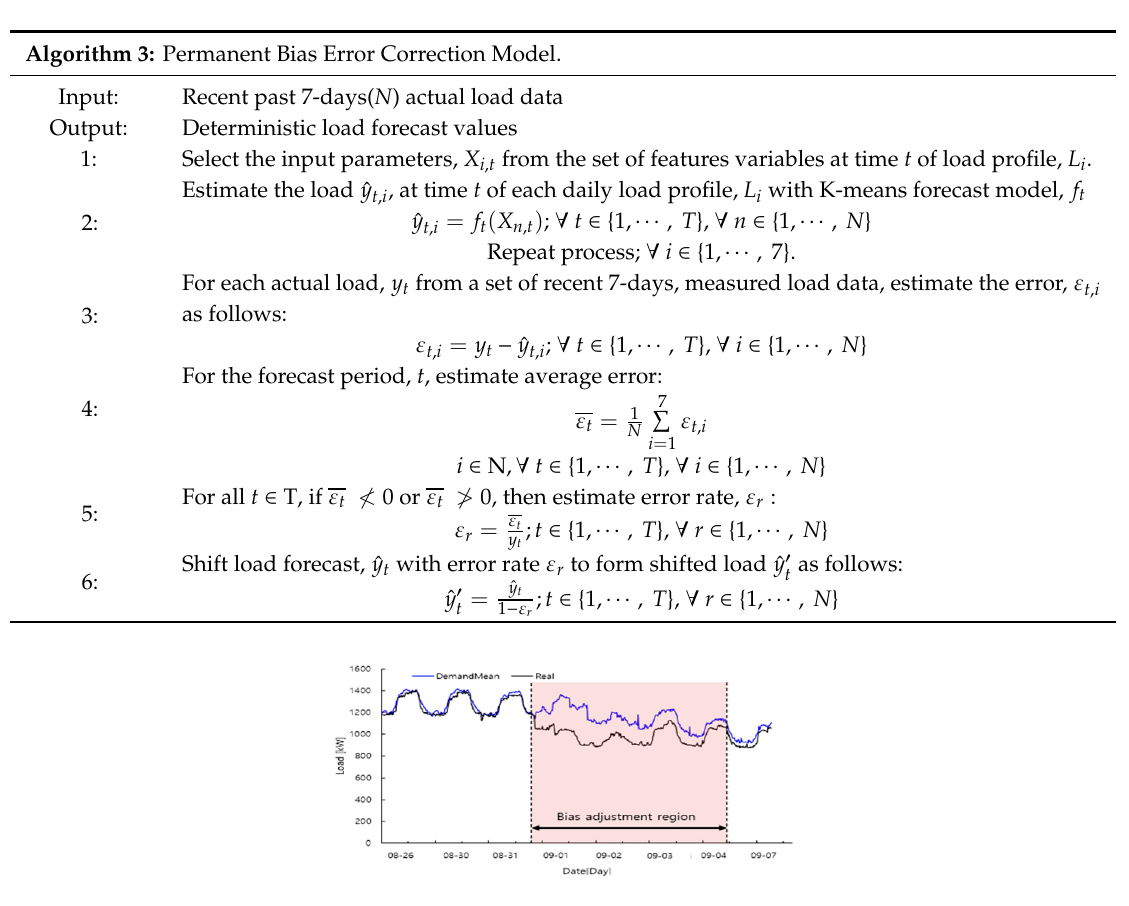
Figure 8. Comparing two demand load profiles.